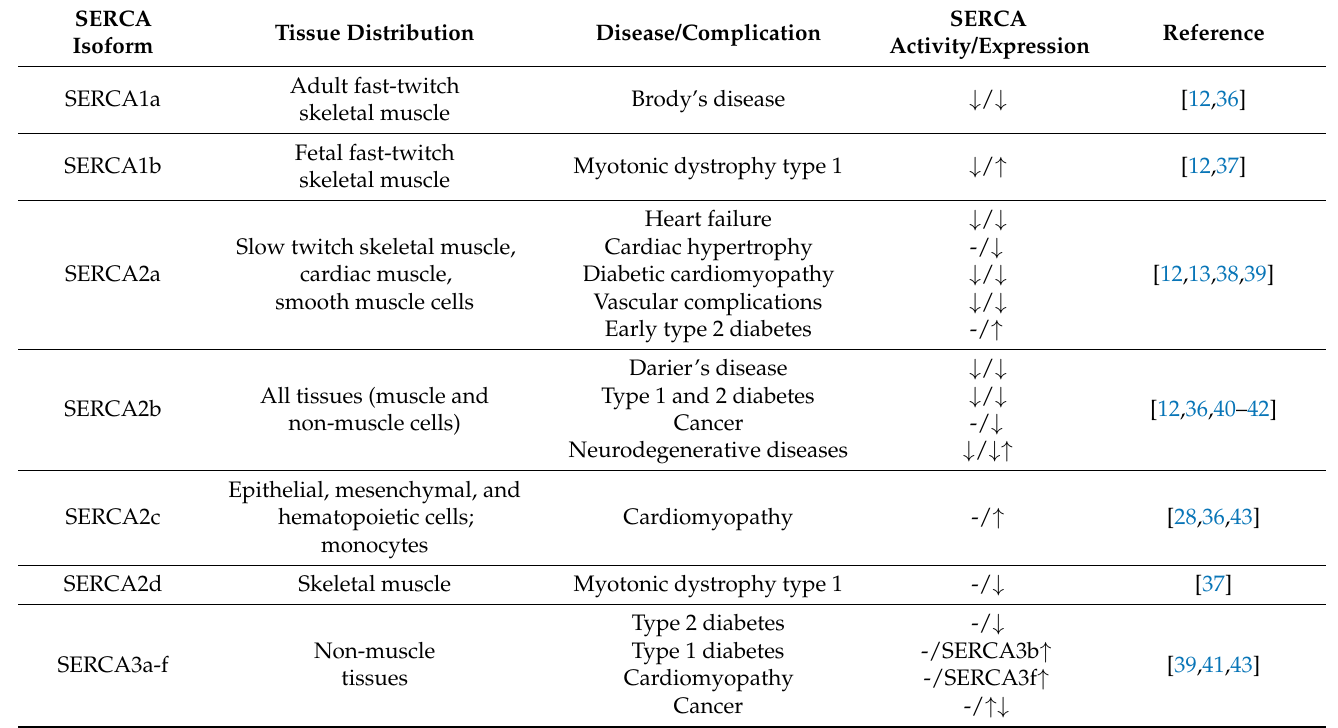
Table 1. The pathophysiological roles of SERCAs in human